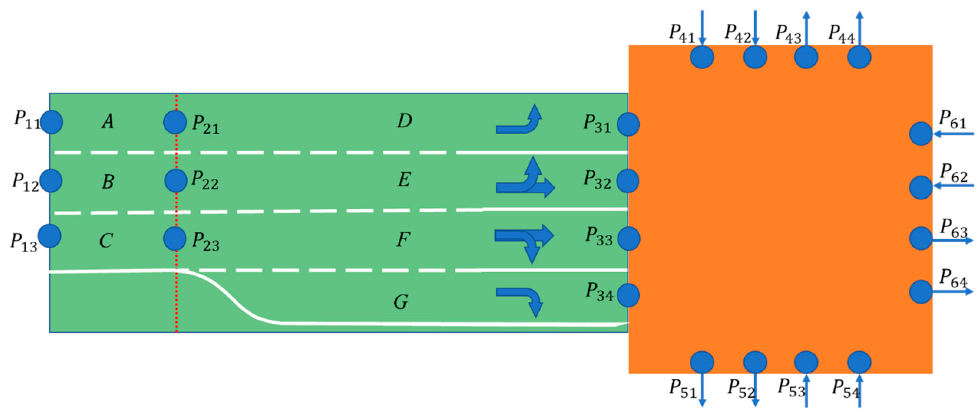
Figure 17. A road (green) with one lane group comprising two lane sections entering an intersection (orange). The lanes are treated as edges represented as A–G, the start and end nodes of which are expressed with P.